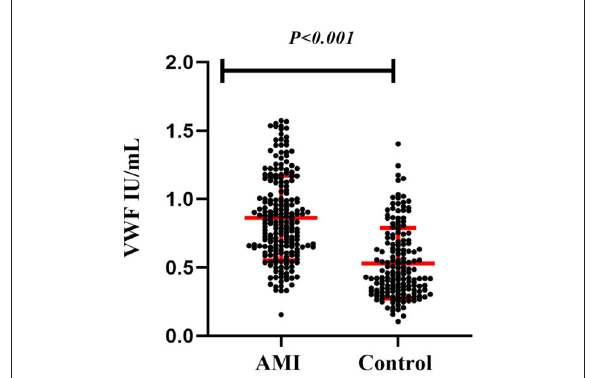
FIGURE1 Comparison of plasma VWF: Ag levels ( x ± s ) between patients with AMI and controls.